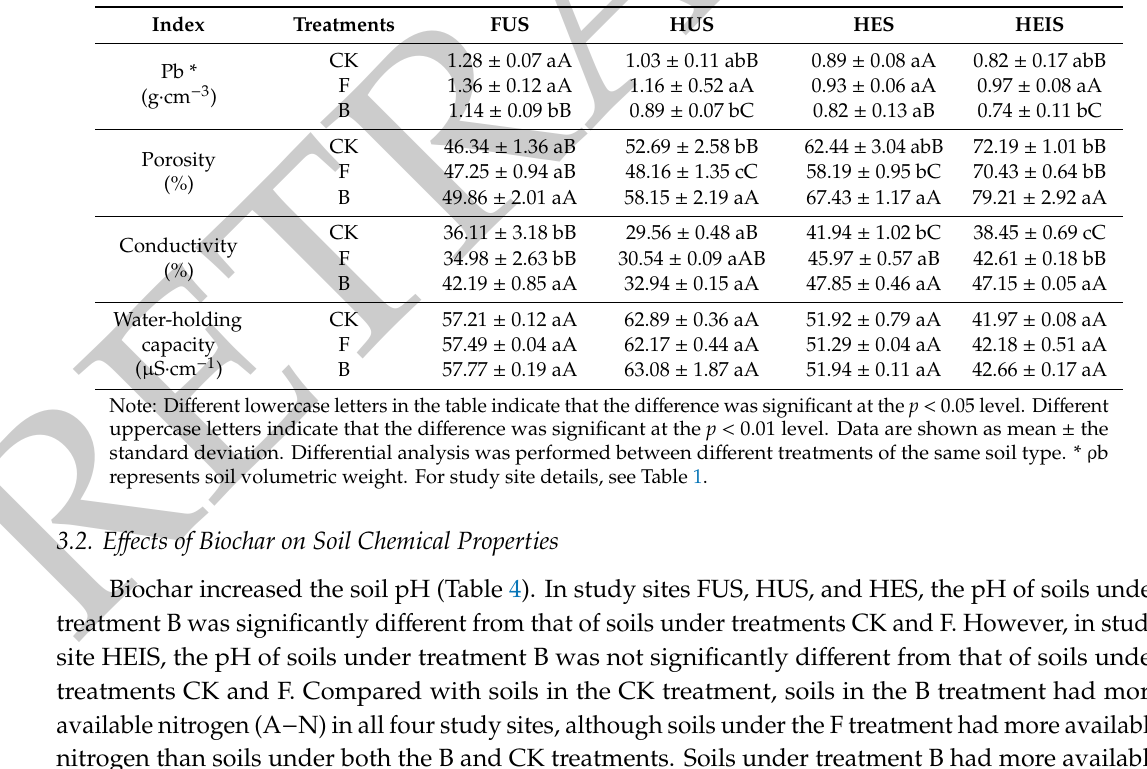
Table 3. E ff ects of biochar on soil physical